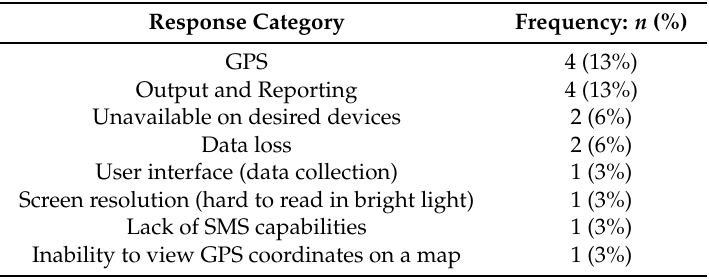
Table 8. Most problematic MST features.